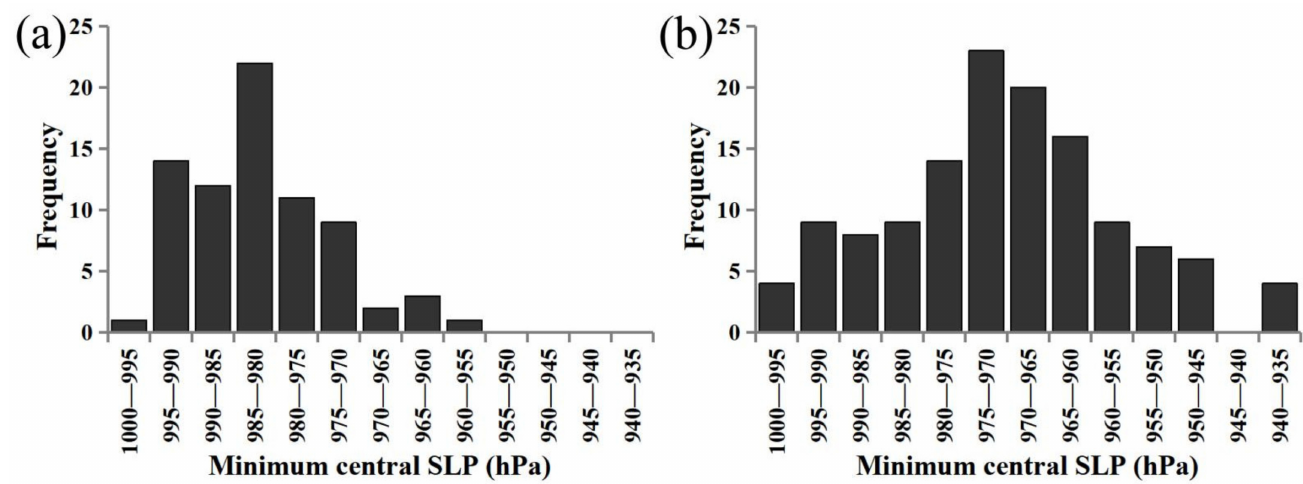
Figure 4. Frequency of minimum central SLP for ECs over ( a ) the Japan Sea and ( b ) Kuroshio/ Kuroshio